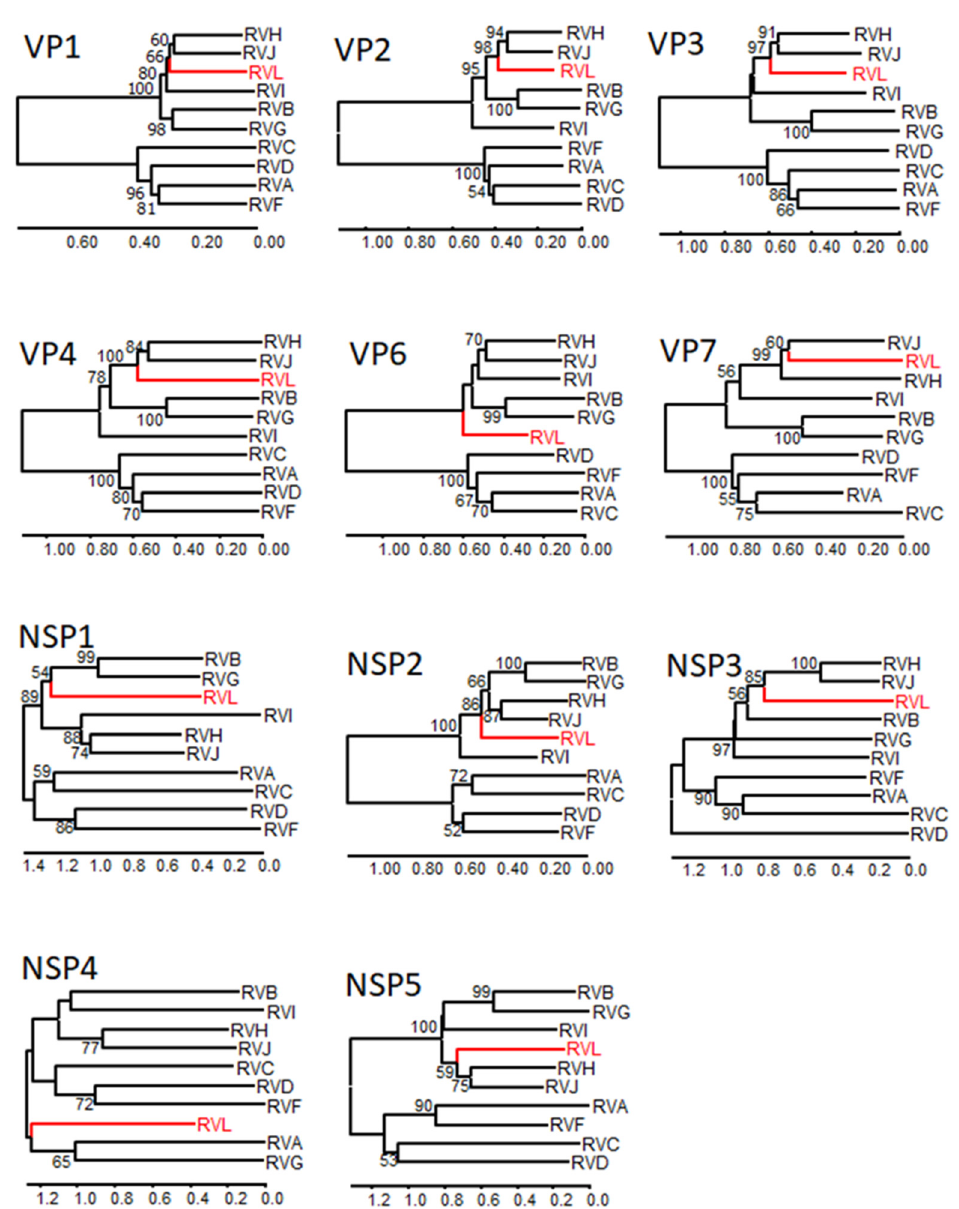
Figure 1. Phylogenetic relationship of RVL with other rotavirus species. The complete deduced amino acid sequences of the encoded proteins of RVL were compared with those of reference strains of the other rotavirus species (as specified in Supplementary Data S1) by the Neighbor-joining method using MEGA X. RVL is marked in red and bootstrap values > 50% are shown. Scaled in amino acid substitutions per site.